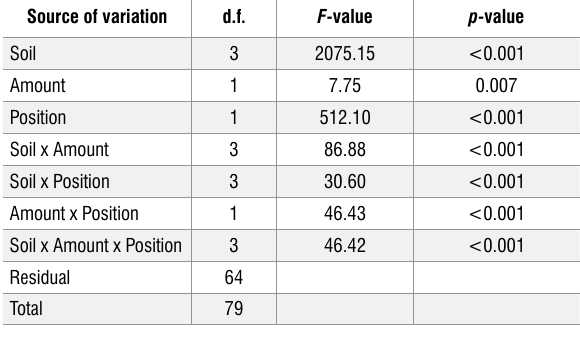
Table 3: Means for active soil carbon content compared with post-hoc Tukey tests (means with letters in common are not different; p =0.05)